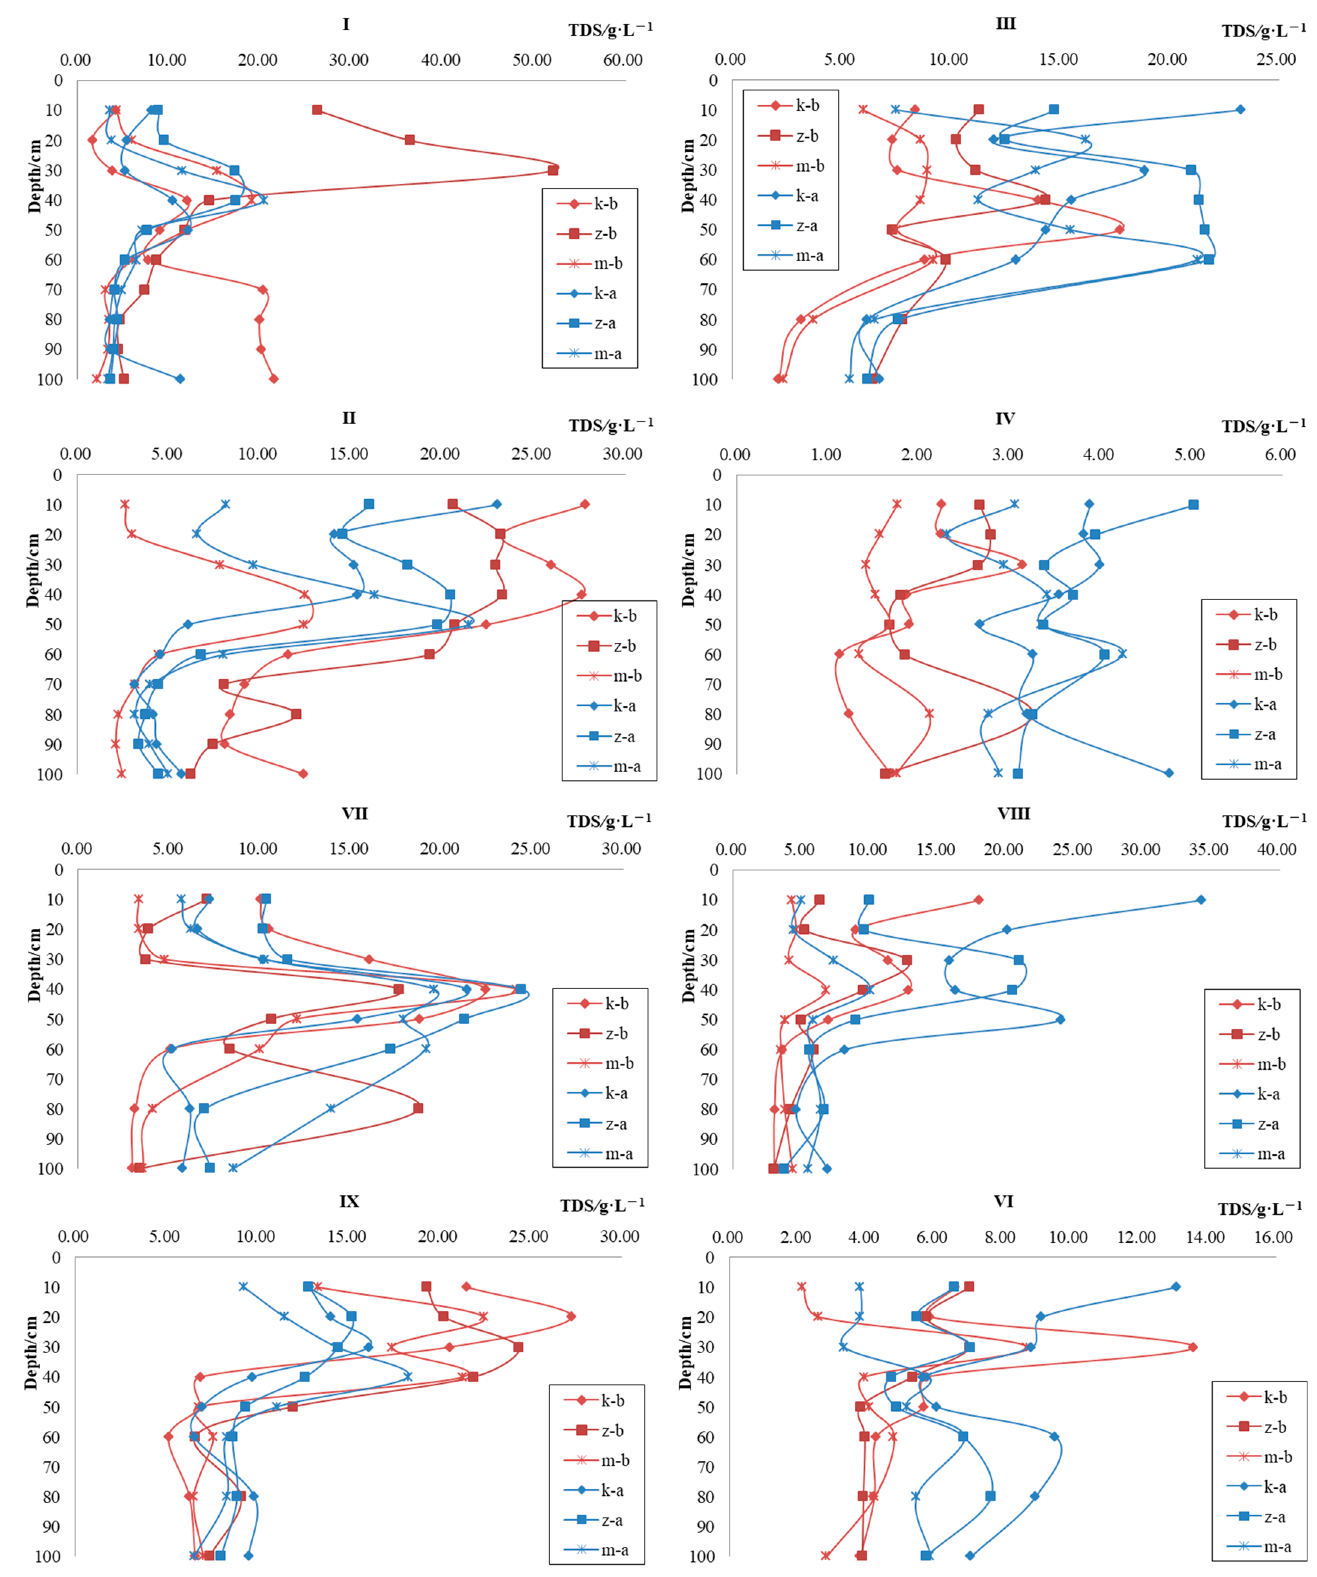
Figure 3. TDS distribution of soil profile in each irrigation scenario before and after the fourth irrigation. Note: the representative meaning of the legend is the same as that in Figure 2.